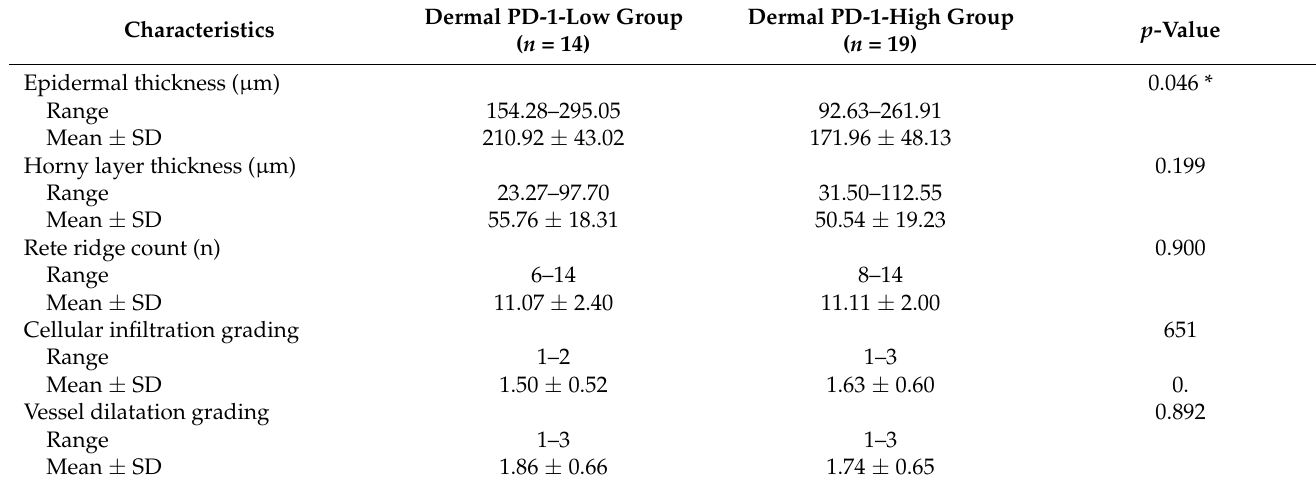
Table 4. Histopathological characteristics of patients with guttate psoriasis according to the dermal expression level of PD-1.